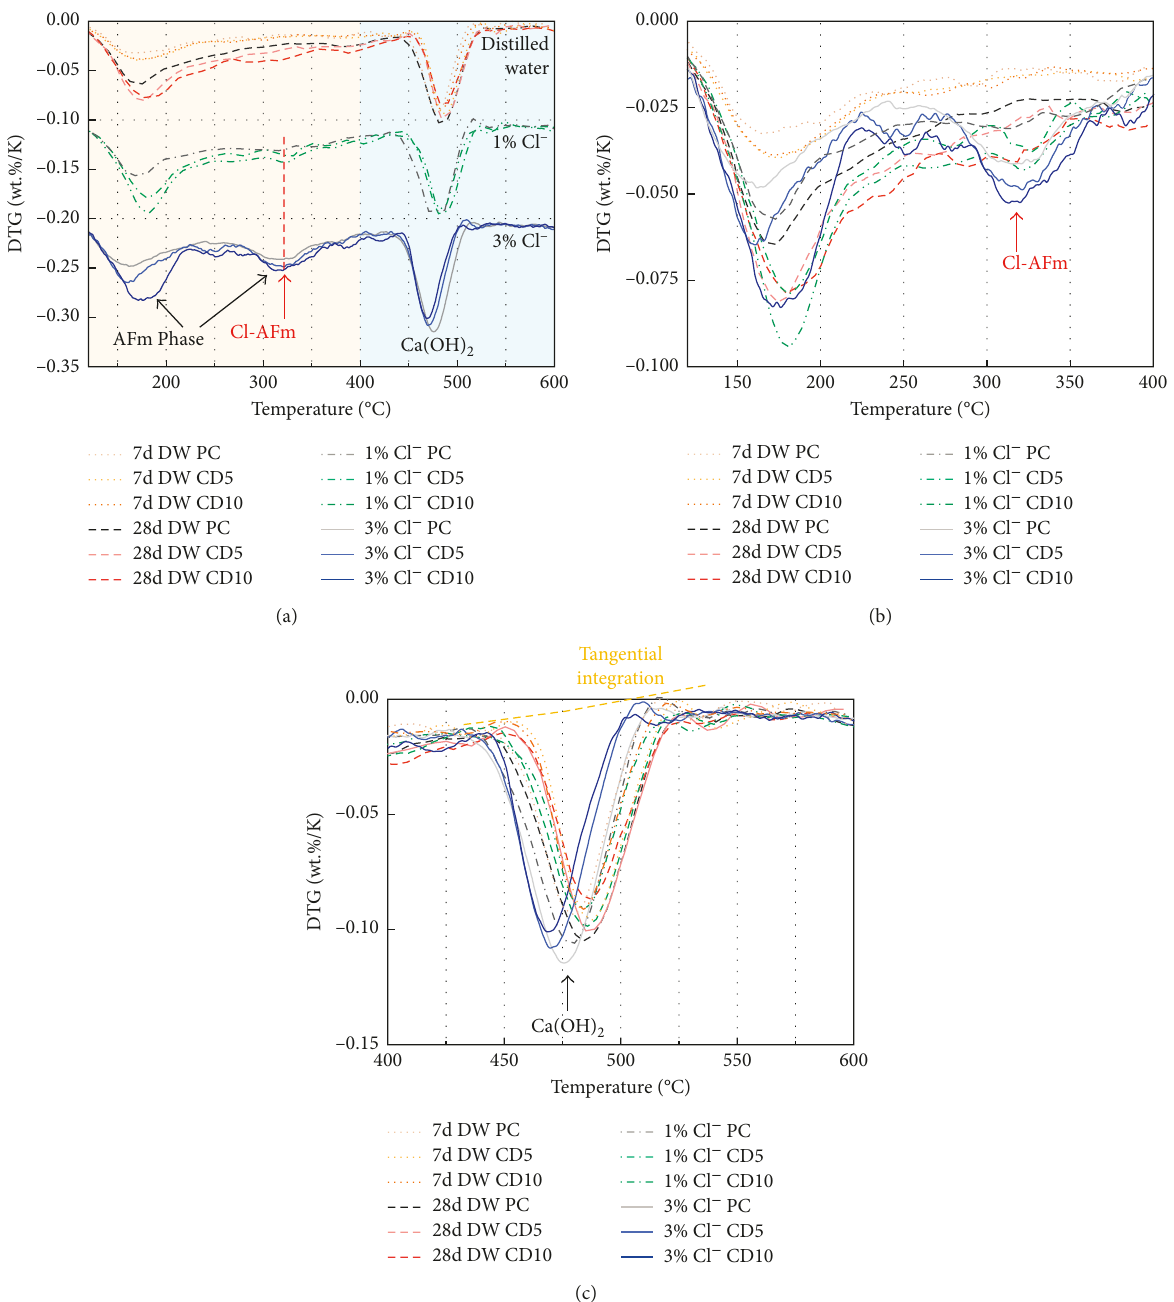
Figure 11: TGA results of PC, CD5, and CD10 reacted with distilled water and chloride solution. (a) The DTG curve between 120 ° C and 600 ° C (offset); (b) the DTG curve between 120 ° C and 400 ° C; (c) the DTG curve between 400 ° C and 600 °